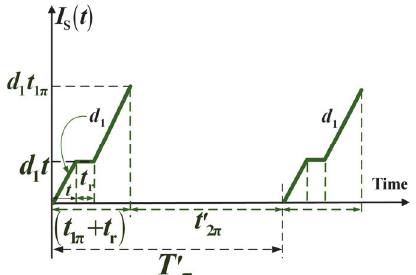
Fig. 3. The scrap level in condition 1 of the proposed system